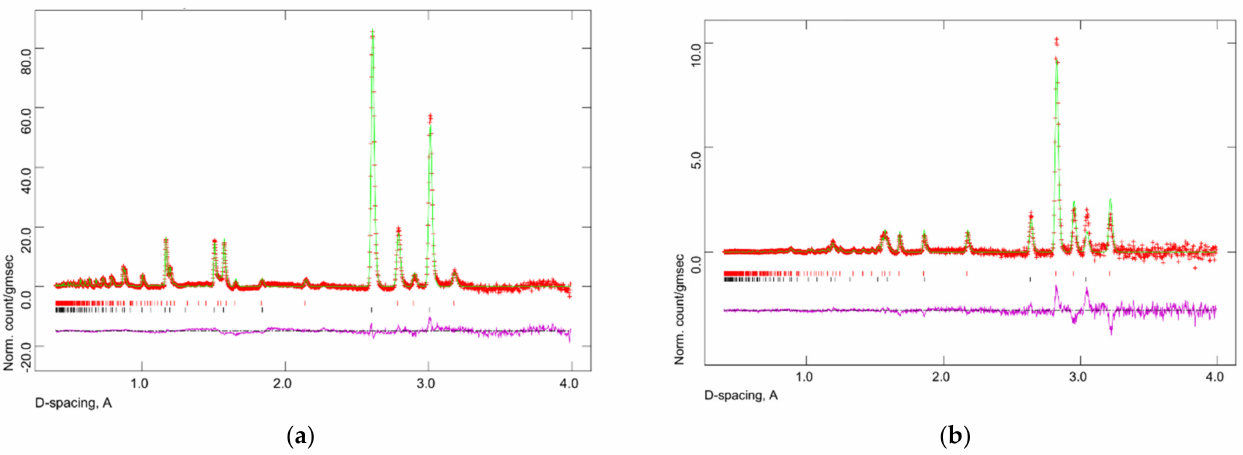
Figure 2. Examples of Rietveld analyses (Room temperature in ( a ), 800 ◦ C in ( b )) of the diffraction data for the YH 1.48 sample. Measured neutron intensities are shown as red crosses, with the Rietveld fitting the green curve through the experimental intensities. Intensities are normalized by incident intensity, and the background is subtracted for clarity. The difference curve between observed and calculated intensity is shown below. The tick marks indicate calculated peak positions for δ - YH 2 (black, bottom row) and α - Y (red, top